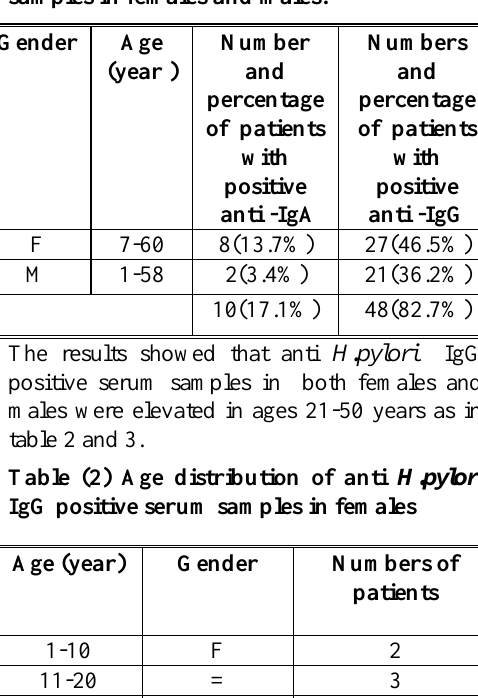
Table (1) Age ,gender and number of anti H.pylori